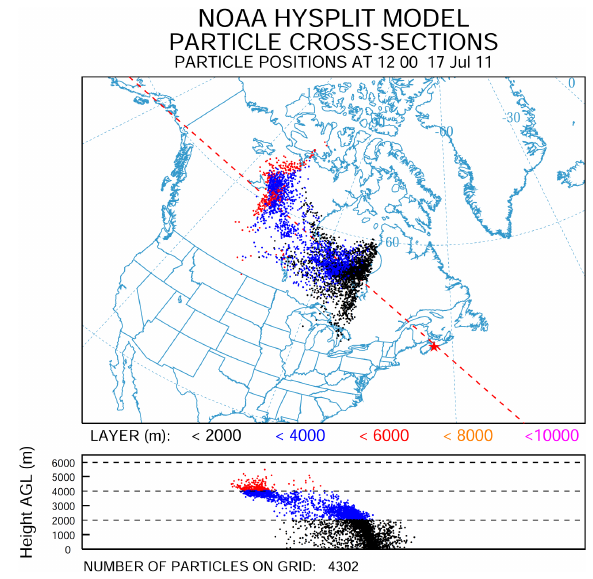
Figure 7. HYSPLIT dispersion model showing location contribu- tions to the lower plume of trace gas and aerosols observed at 00:00UTC from the DGS on 21 July 2011. Particles were initial- ized between 0.5 and 1.5km above the DGS (marked by red star) and advected back by 84h. A significant overlap is observed be- tween the model footprint and regions of wildland fires in western Ontario (see Fig. 1). The lower panel shows the vertical distribution of particles along the red dashed line in the upper panel with the majority of the particles still in the lowest 4km of the